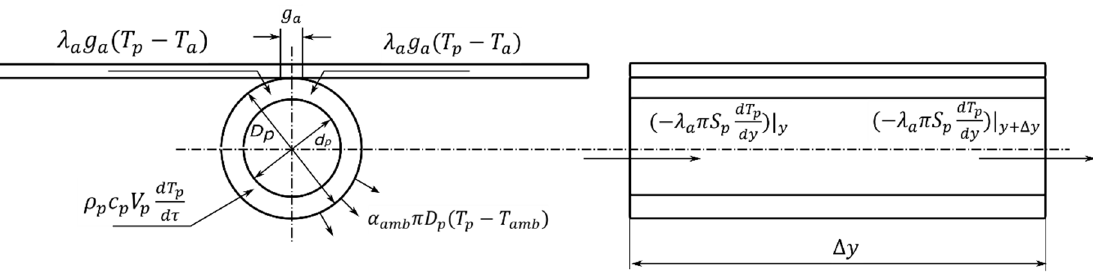
Figure 6. The energy balance of the flow pipes.